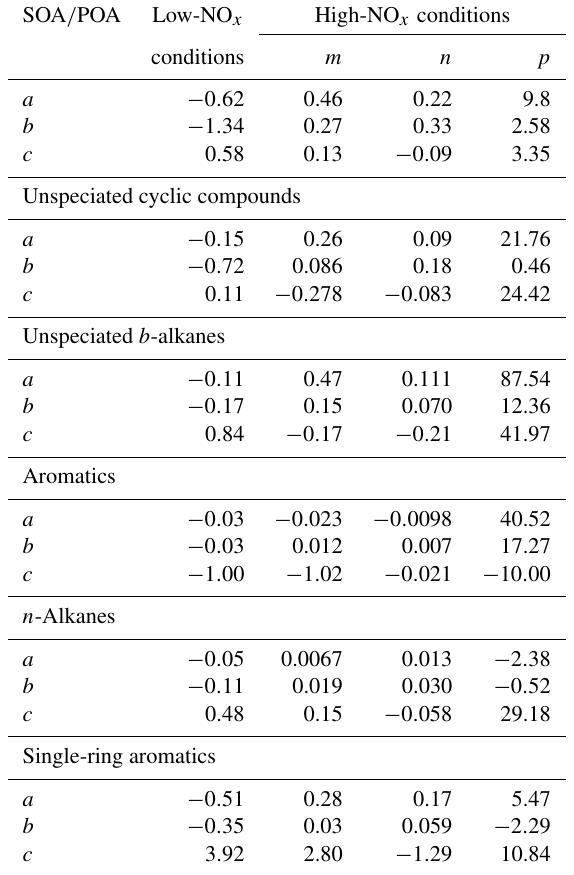
Table 1. Coefficient of parameterization between SOA / POA and photochemical